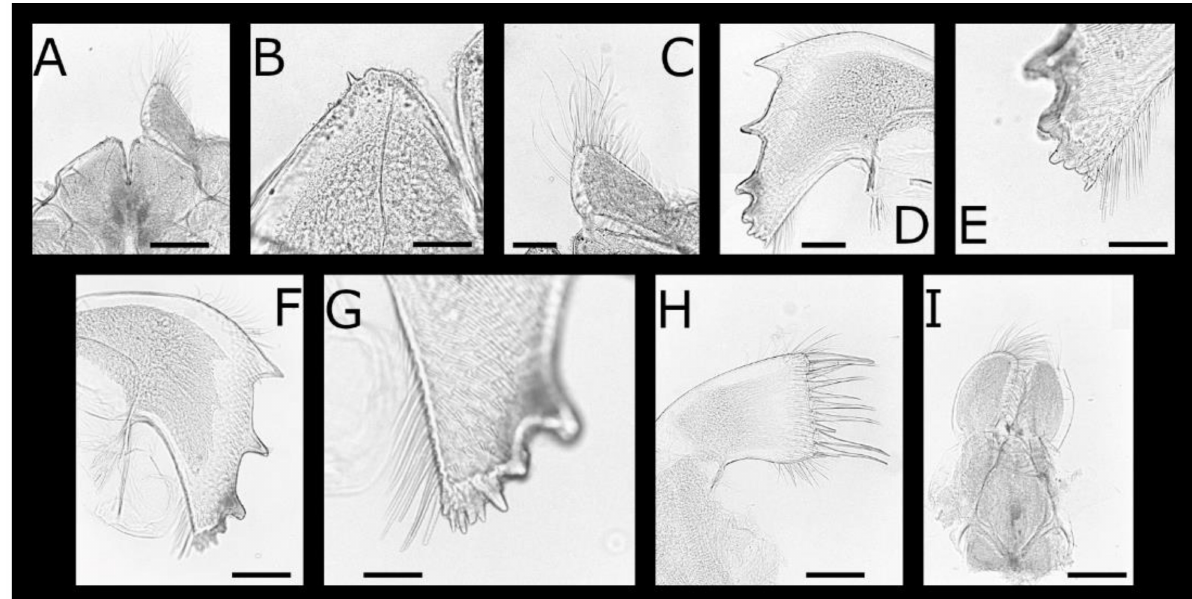
Figure 10. Euacasta acutaflava sp. nov. mouthparts of holotype (WAM C58744) ( A ) labrum and right mandible palp; ( B ) close up of crest of labrum; ( C ) right mandible palp; ( D ) right mandible; ( E ) close up of inferior angle of right mandible; ( F ) left mandible; ( G ) close up of inferior angle of left mandible; ( H ) left maxillule; ( I ) left and right maxillae. Scale bars: A,